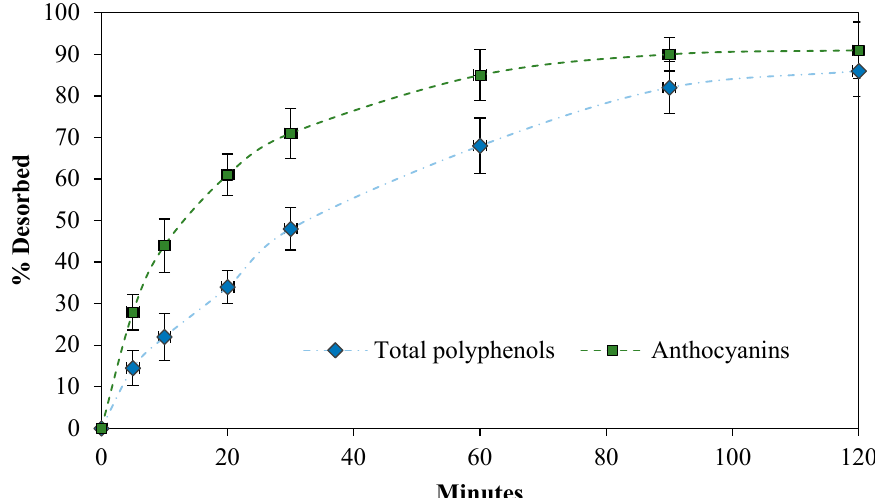
Figure 10. Release profile of polyphenols and anthocyanins from powder formed by the incorporation of H. macrocarpa on nanocellulose.